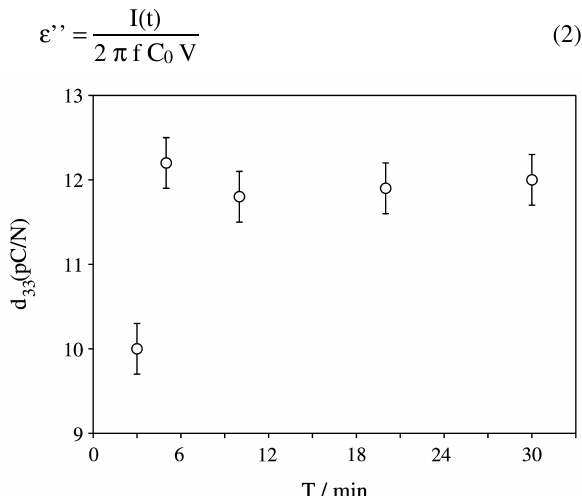
Figure 3. Variation of piezoelectric coefficient with the poling time for PZT/PU/C composite with 59/40/1 vol. %.